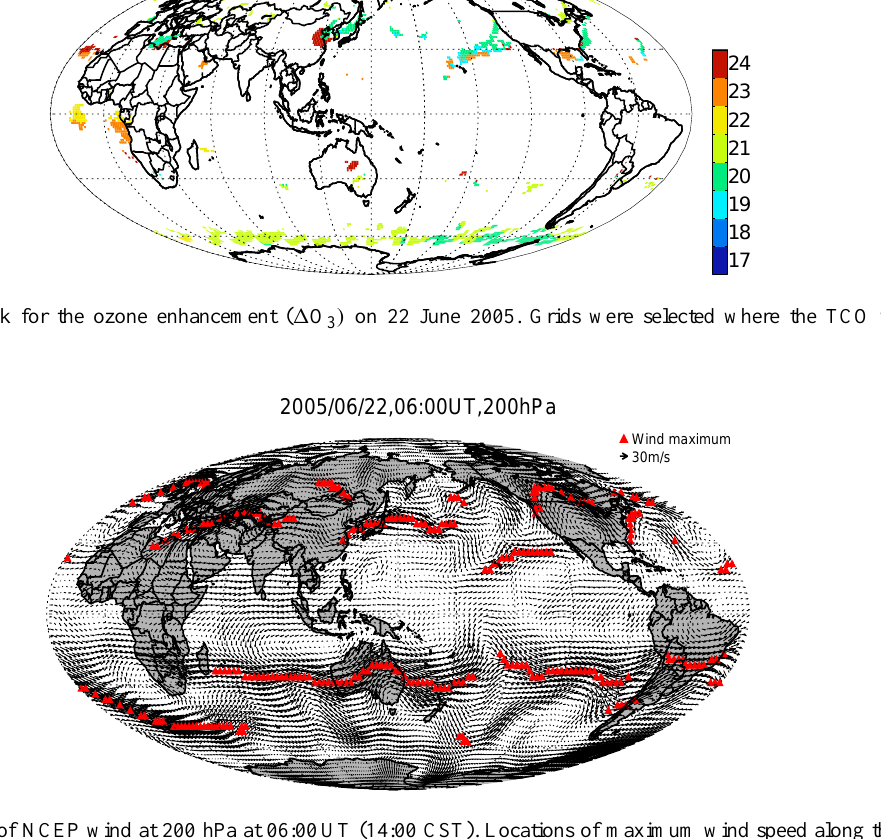
Figure 8. A global map of NCEP wind at 200 hPa at 06:00UT (14:00 CST). Locations of maximum wind speed along the longitude are denoted by red